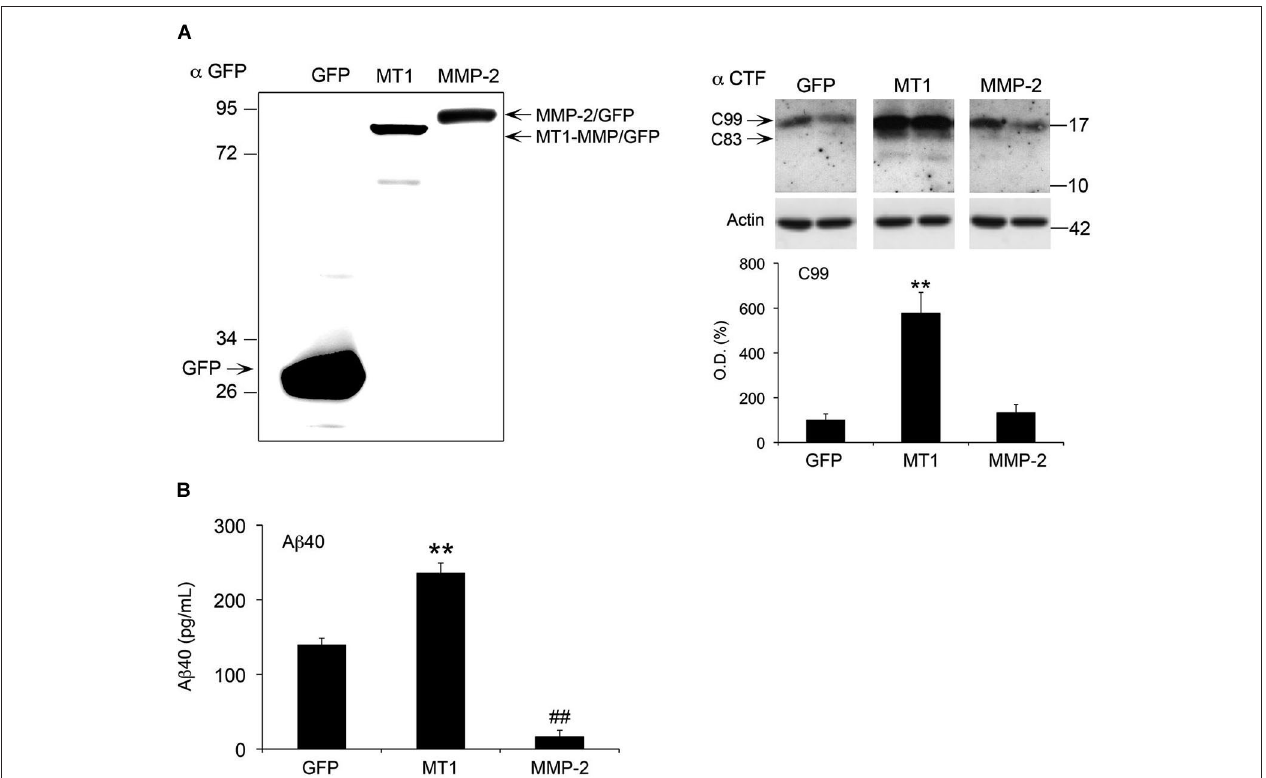
values are the mean ± SEM of four independent cultures representing the percentage of variation in optical density (O.D.). ** p < 0.01, MT1 vs . GFP and MMP-2; ANOVA followed by Tukey’s test. (B) ELISA assay showing opposite effects on A β 40 levels in the supernatant of HEKswe cells 48 h post-transfection. MT1-MMP significantly induced A β production, whereas MMP-2 nearly abolished it. Values are the mean ± SEM of four independent cultures. ** p < 0.01, MT1 vs . GFP and MMP-2; ## p < 0.01, MMP-2 vs . GFP. ANOVA followed by Tukey’s